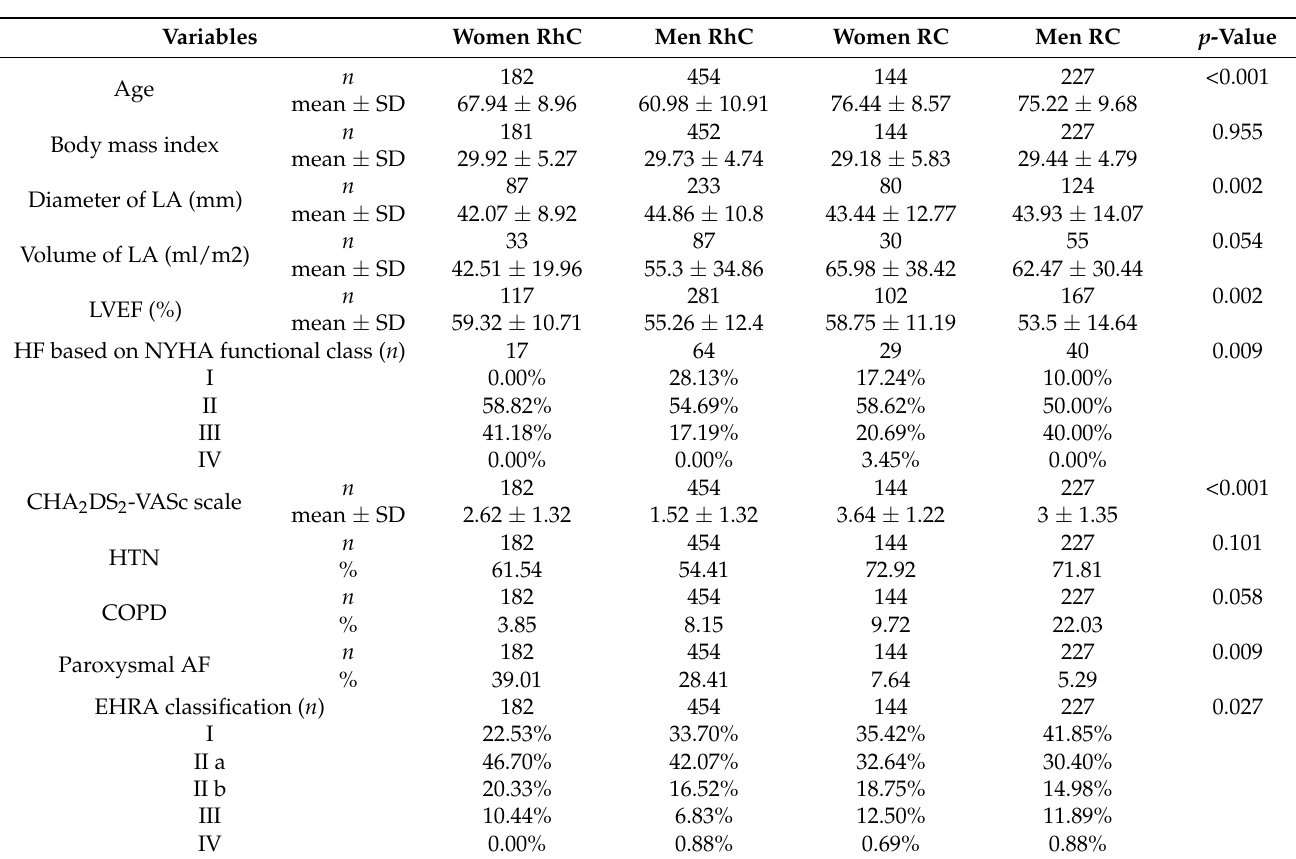
Table 1. Basal characteristics.